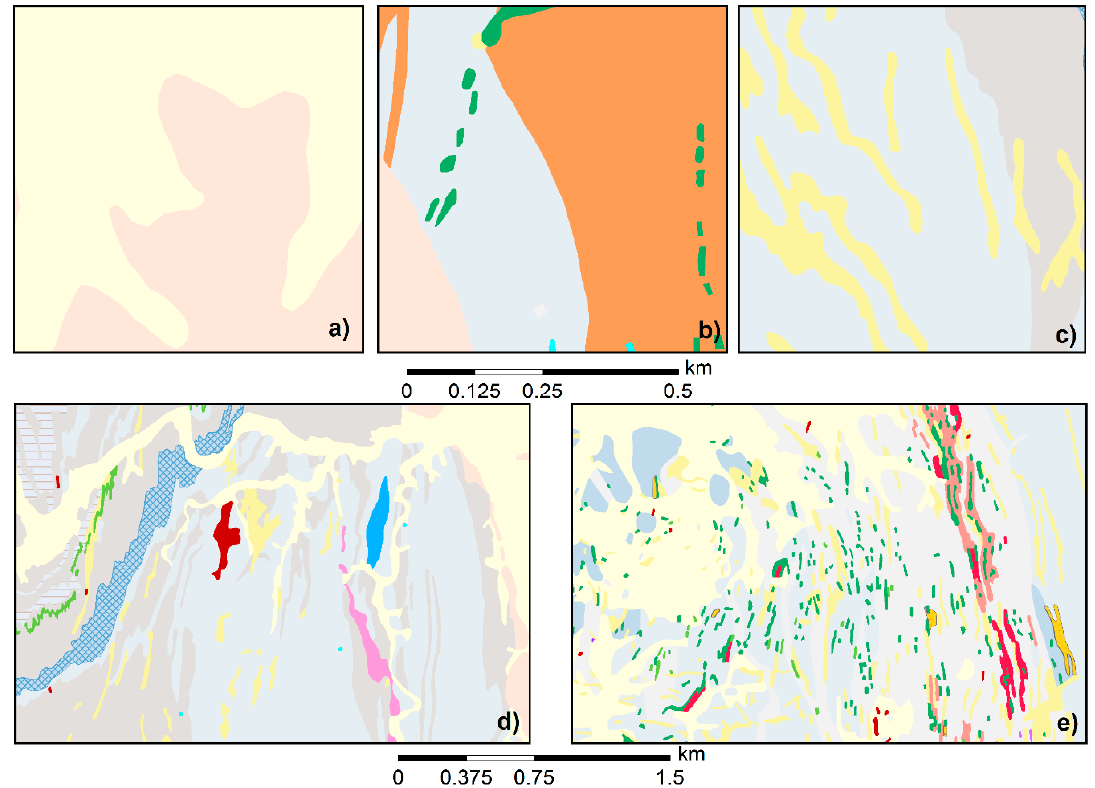
Figure 1. Some excerpts from geological maps, ordered by the complexity of the shapes and structures of geological units. ( a ) A few large polygons with simple shapes. ( b ) Several small polygons of the same geological unit and with similar geometrical properties. ( c ) Elongated polygons of the same unit with similar geometrical properties. ( d ) A complex type with tree-like dendritic shapes. ( e ) A combination of all of the above-mentioned shapes and structures.